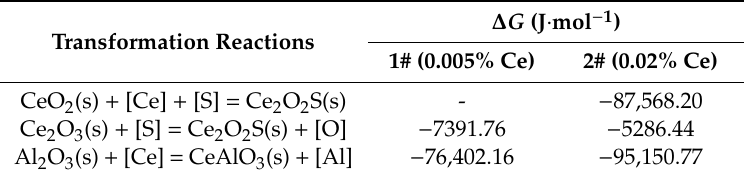
Table 6. The ∆ G for mutual transformation of REM inclusions in LDX2101 duplex stainless steels containing 0.005% and 0.02% Ce at 1873